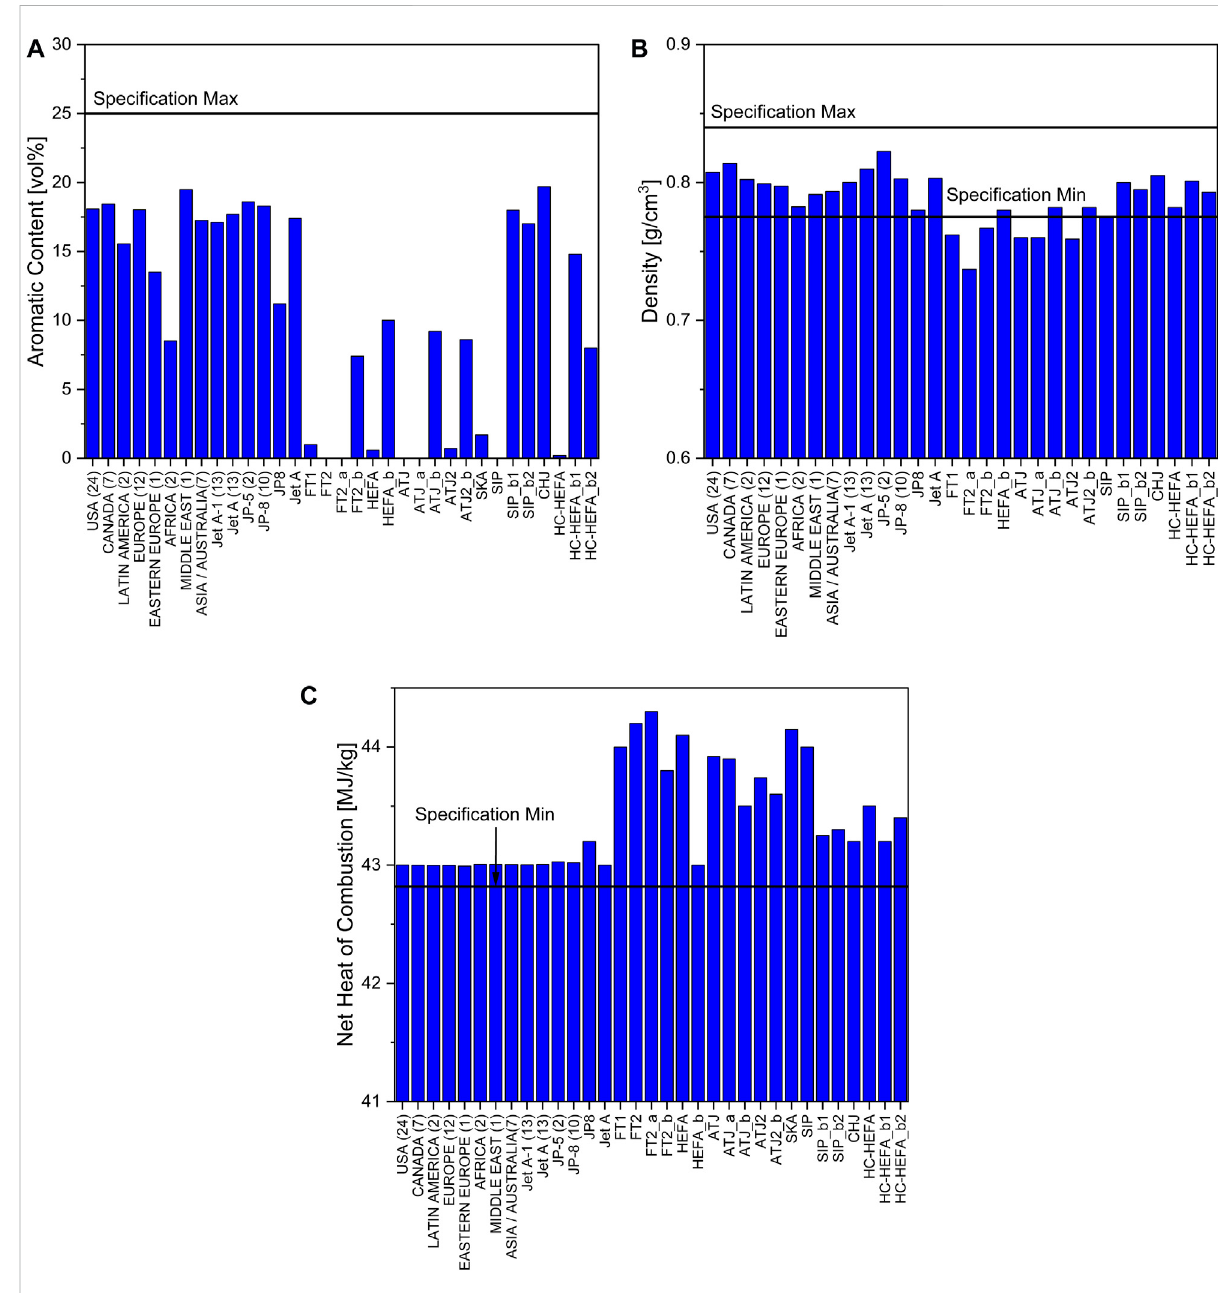
FIGURE 7 Results for WFS and SAF (A) aromatic content, (B) density, (C) net heat of